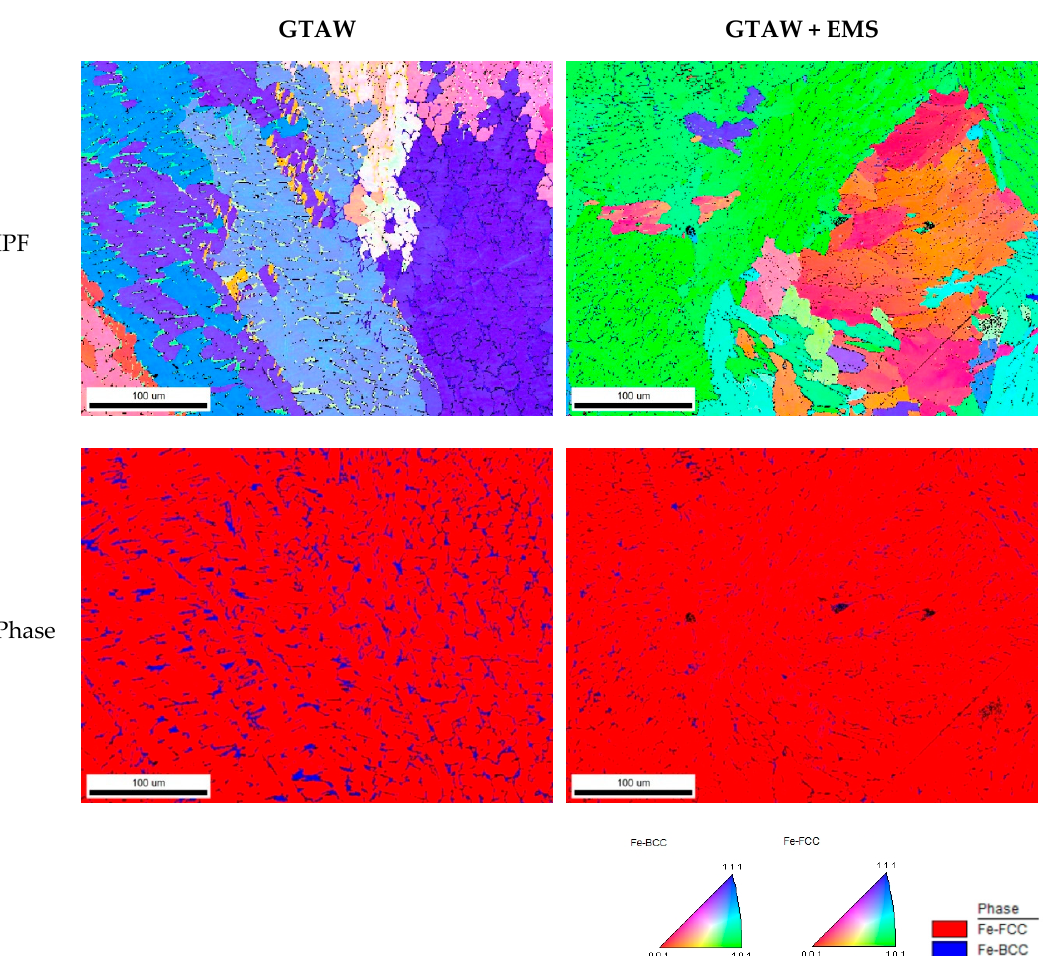
Figure 8. The inverse pole figure (IPF) maps and the distribution of austenitic and ferritic phases in the BOP welds.